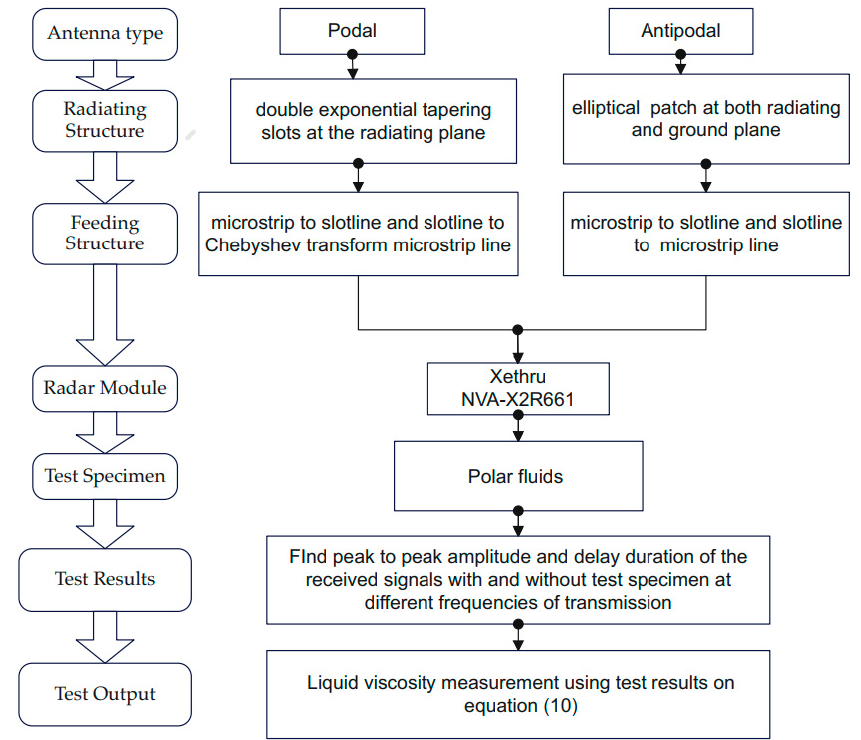
Figure 15. Graphical illustration of the proposed idea.